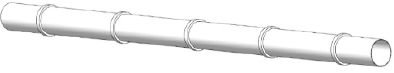
Figure 8. Finite period pipe structure.